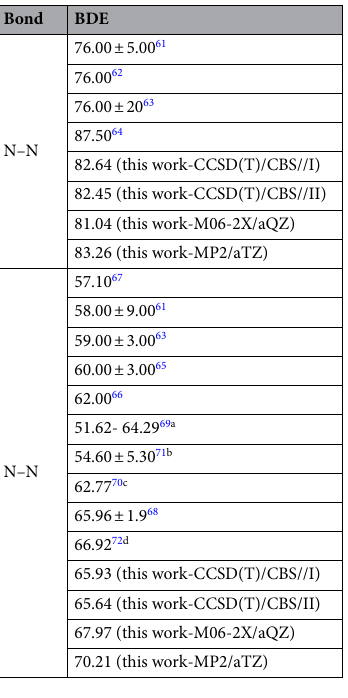
Table 3. The computed BDEs of the N–N and N–H bonds through homolytic dissociation in the N 2 H 4 molecule. I: refers to the correction values at MP2/aTZ level. II: refers to the correction values at M06-2X/ aQZ level. a Calculated by 7 methods. b Calculated for 11 hydrazine moieties. c The average value of eight computational methods. d Computed by the G2MP2